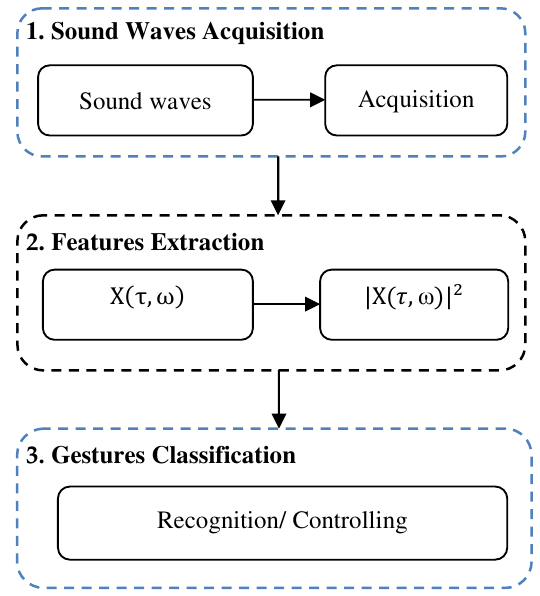
Figure 2. The diagram of the basic stages of gestures recognition system and